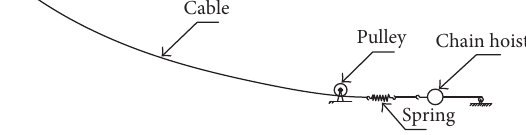
Figure 7: Overview of the test model.